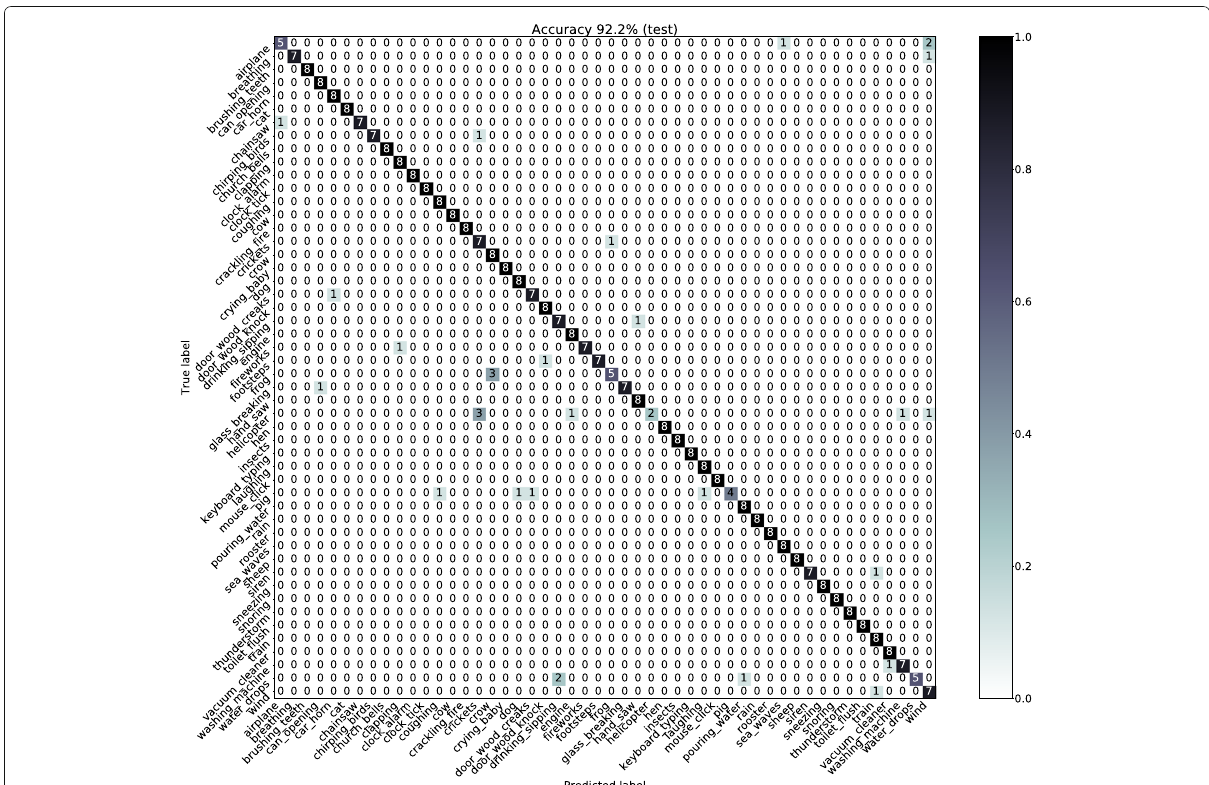
Fig. 4 The confusion matrix (CM) of the best prediction on the fifth fold of the ESC-50 database. The highest confusion can be observed for the classes “frog” and “crow”